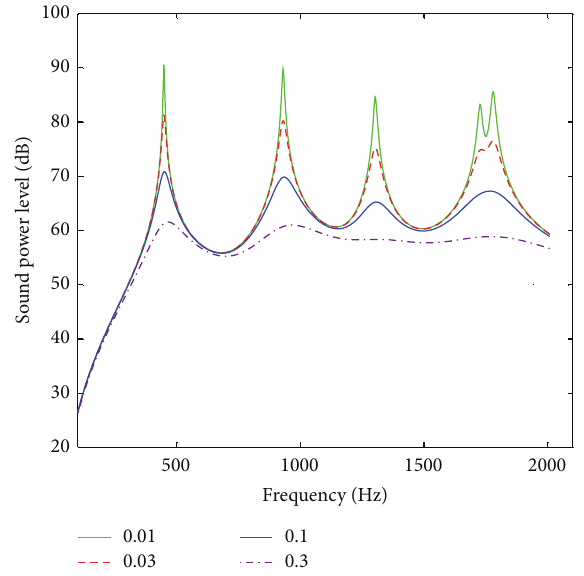
Figure 13: The effect of damping loss factor on sound radiation of FGM